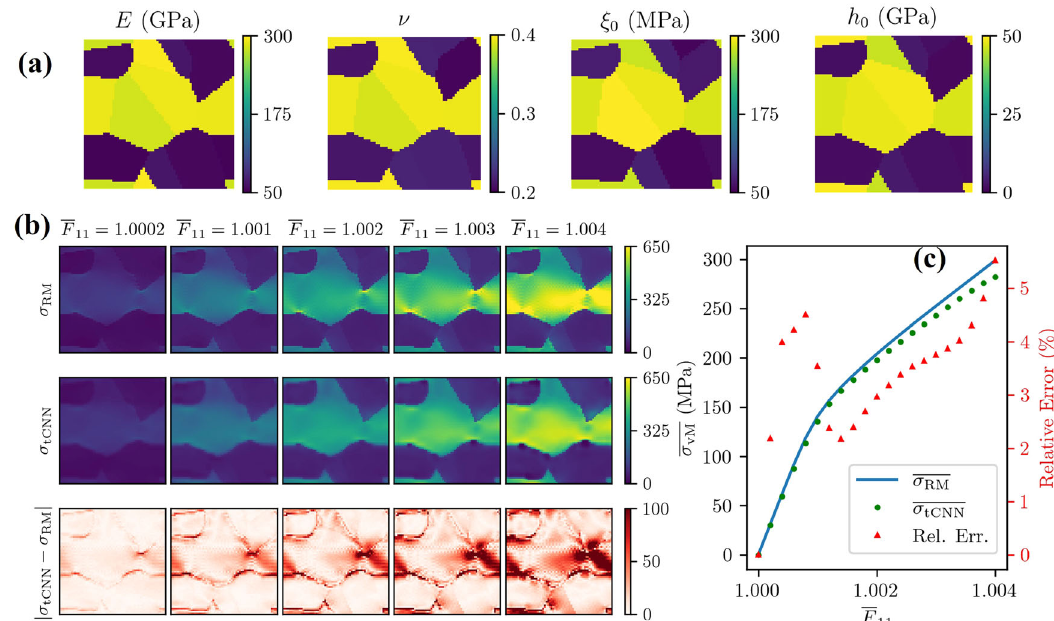
Fig. 4 Case 1 (high-contrast) test microstructure subject to uniaxial extension along the horizontal axis. a Young ’ s modulus E , Poisson ’ s ratio ν , initial fl ow resistance ξ 0 , linear isotropic hardening modulus h 0 . b Results for σ RM (above), σ tCNN (middle), ∣ σ tCNN − σ RM ∣ (below) (all MPa), at different F 11 . c σ RM (blue curve), σ tCNN (green points), and relative error (red triangles) given by 100 ð σ tCNN (cid:3) σ RM Þ = σ RM versus F 11 .